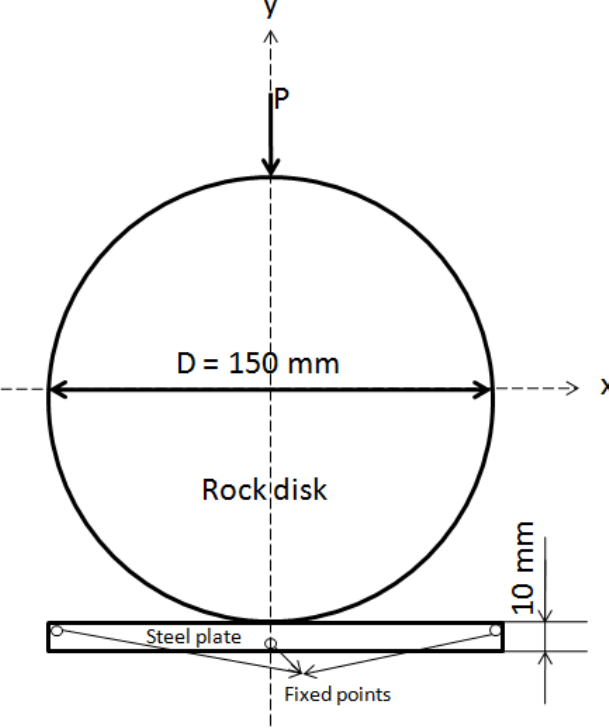
Figure 4. Geometric parameters and loading mode of the model. Table 1. Mechanical parameters of the Brazilian disc